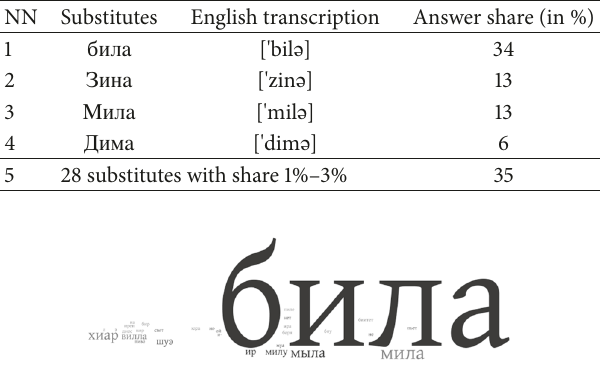
Figure 5: «Word cloud» for phonogram « 3KS1 »: native Russian speakers at signal-to-noise ratios = −9 and − 12dB [Base: 𝑛 = 90 ].